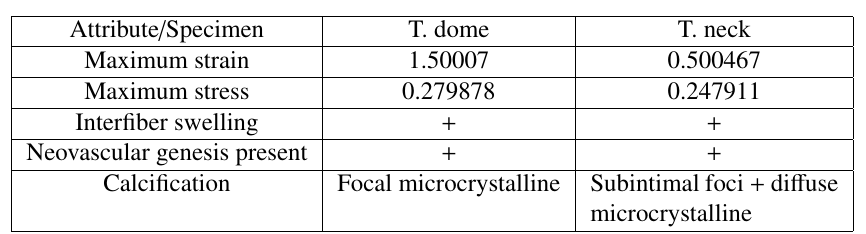
Table 2: Comparison of mechanical test and histological